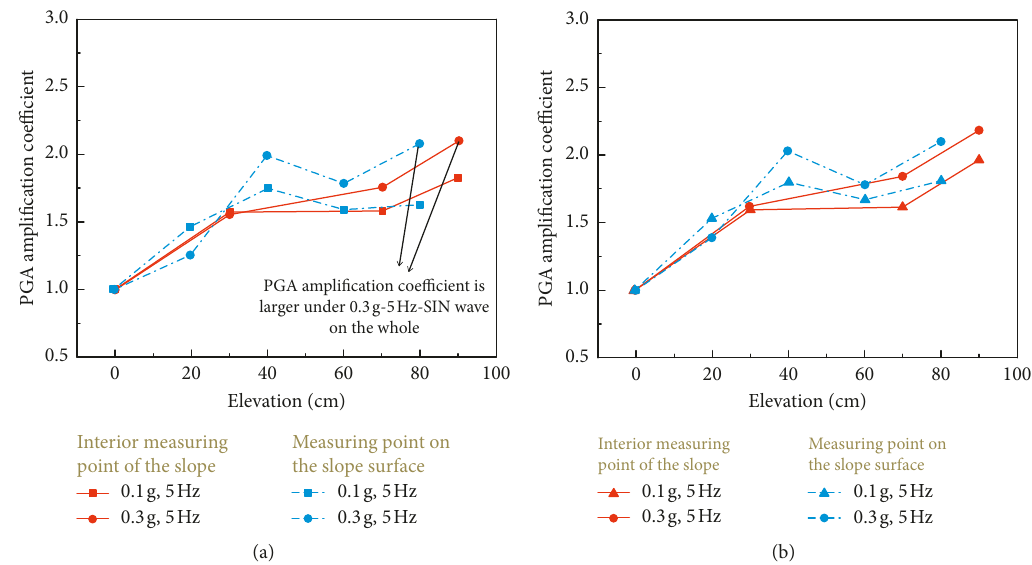
Figure 19: (a) PGA amplification coefficients of convex slope under different sine waves. (b) PGA amplification coefficients of concave slope under different sine